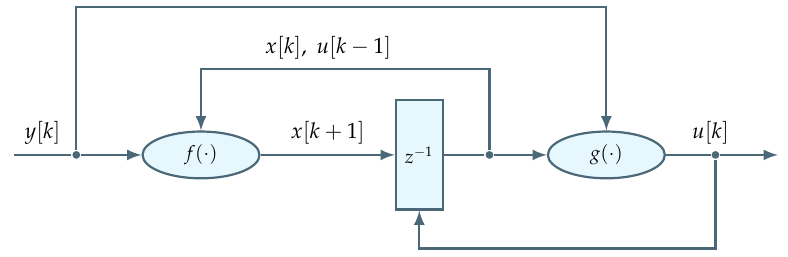
Figure 13. Discrete-time state-space regulator visualized as a Mealy FSM.